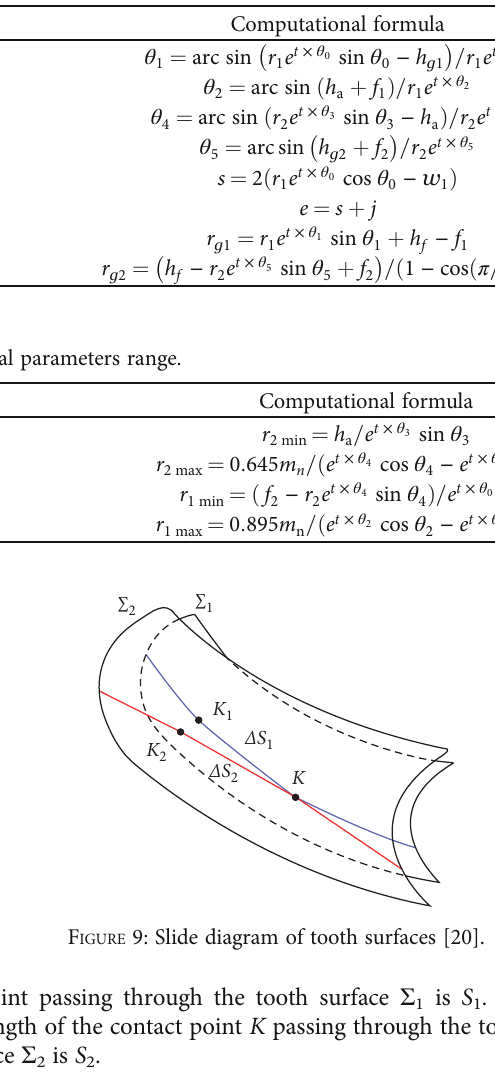
T ABLE 1: Calculation formulas of the tooth pro fi le parameters.